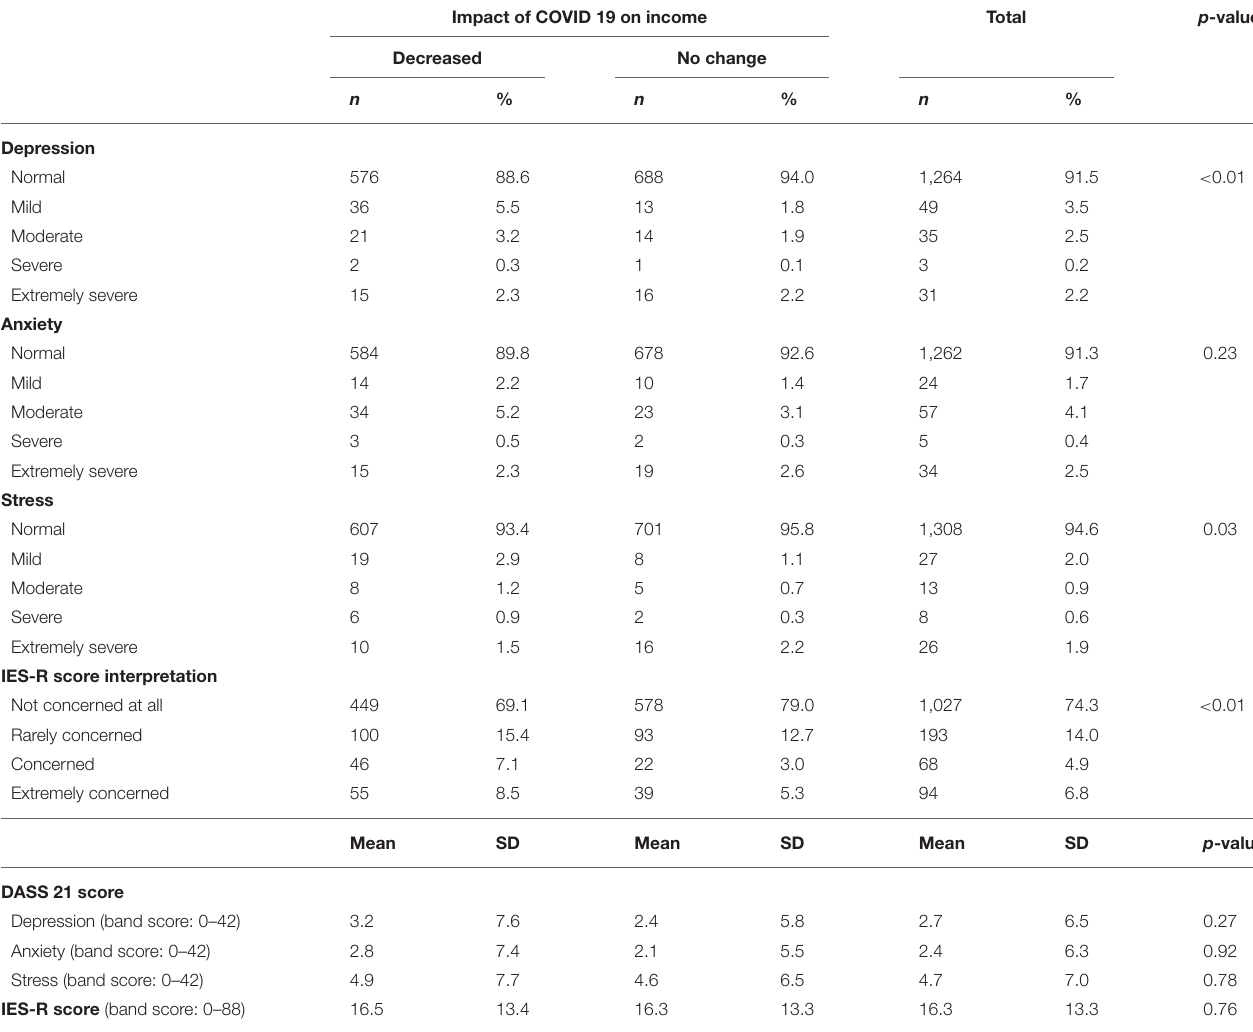
TABLE 3 | Mental well-being of respondents during